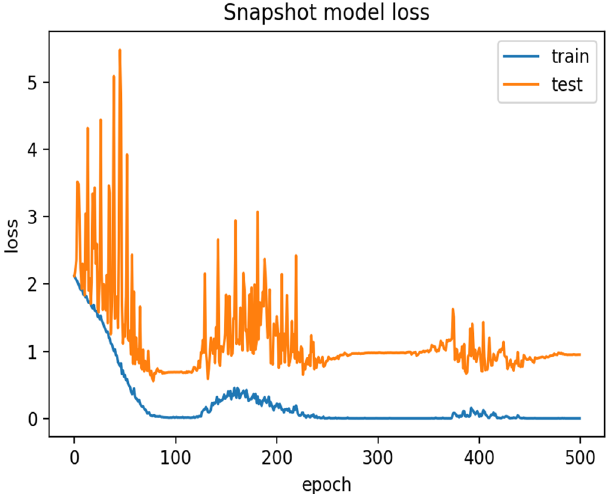
Figure 8. Graph represents loss during the training of IRFacExNet model.